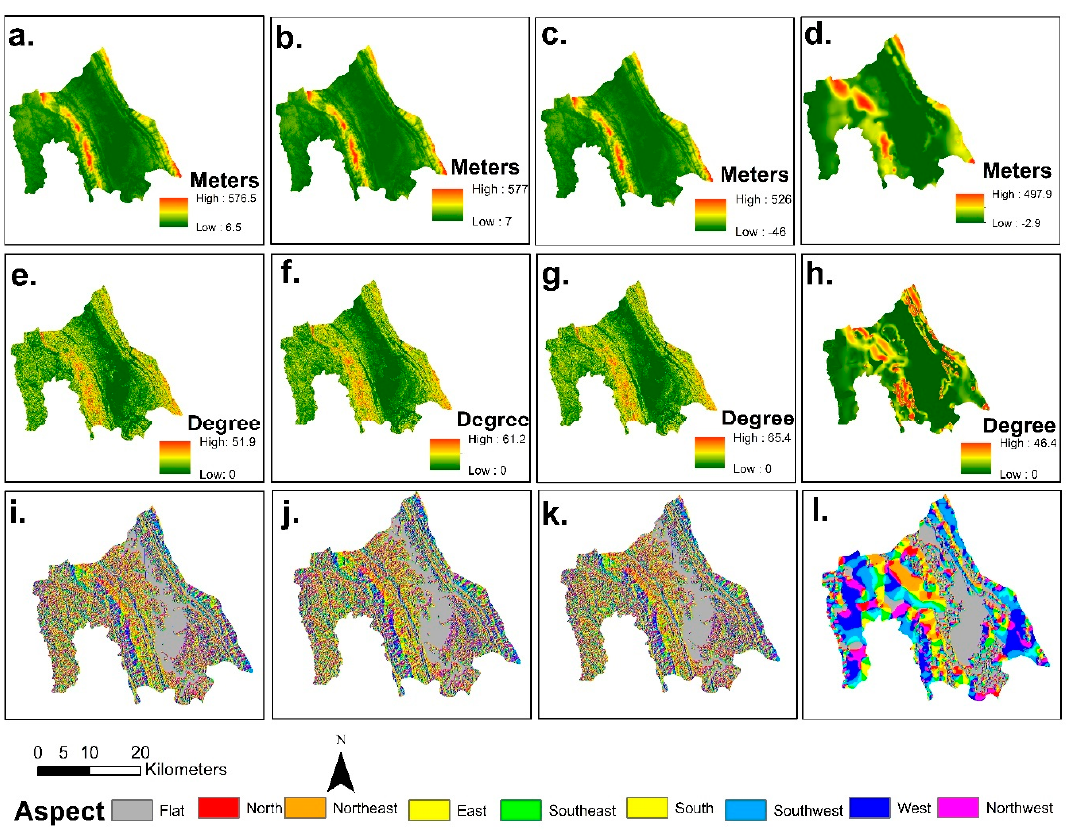
Figure A1. Spatial relationship between causal factors and landslides. Figure A1. Landslide Causal Factors: ( a ) Elevation (ASTER); ( b ) Elevation (SRTM); ( c ) Elevation (ALOS PALSAR); ( d ) Elevation (SOB); ( e ) Slope (ASTER); ( f ) Slope (SRTM); ( g ) Slope (ALOS PALSAR); ( h ) Slope (SOB); ( i ) Aspect (ASTER); ( j ) Aspect (SRTM); ( k ) Aspect (ALOS PALSAR); ( l ) Aspect